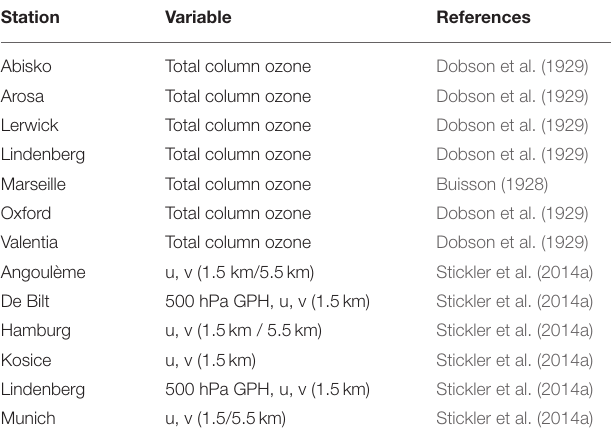
TABLE 3 | Total column ozone and upper-air series used for the assimilation experiments